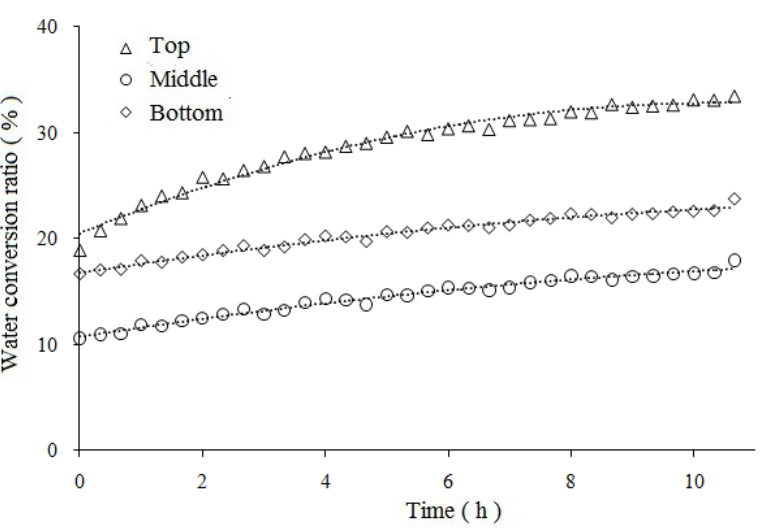
Figure 11. Amplitudes of 5–15.5 h period in Figure 9 (for the same reason as above, 5 h, 15.5 h in Figure 9 were respectively translated into 0 h, 10.5 h. Top: water conversion ratio = −0.0011 × reaction time 2 + 0.0237 × reaction time + 0.2053, R 2 = 0.9829; Middle: water conversion ratio = −0.0003 × reaction time 2 + 0.009 × reaction time + 0.1075, R 2 = 0.9793; Bottom: water conversion ratio = −0.0003 × reaction time 2 + 0.0087 × reaction time + 0.1679, R 2 = 0.9793. Reaction time implies the same as above).